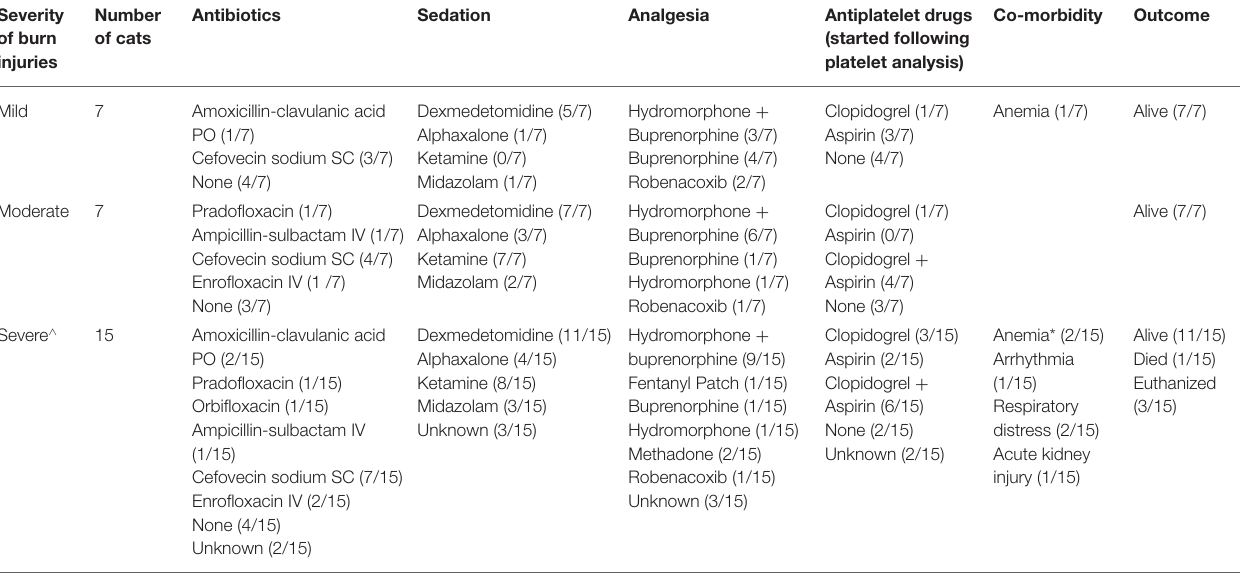
TABLE 2 | Therapies, sedatives, co-morbidities and outcomes of 29 cats with naturally occurring wild fire injury and smoke inhalation. Severity Number Antibiotics Sedation Analgesia Antiplatelet drugs of burn of cats injuries